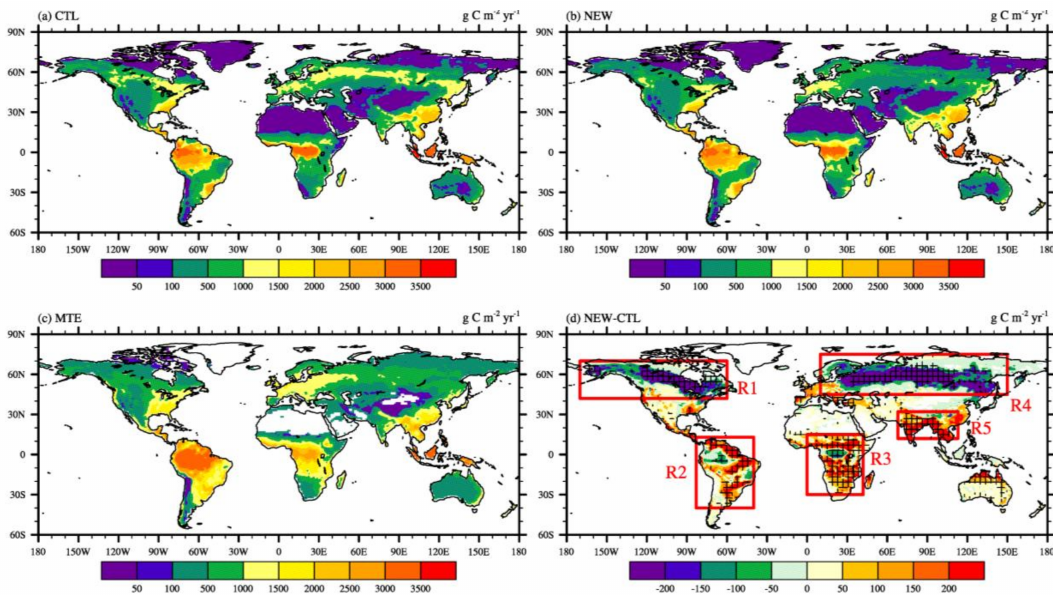
Figure 5. Annual gross primary production (GPP, g C m − 2 year − 1 ) over 1982–2005 for: ( a ) the CTL run; ( b ) the NEW run; ( c ) MTE; ( d ) the difference between NEW and CTL. (Grid shaded regions are significant at the 95% confidence level according to Student’s t -test, and red frames outline grouped regions with significant differences, denoted as R1, R2, R3, R4, and